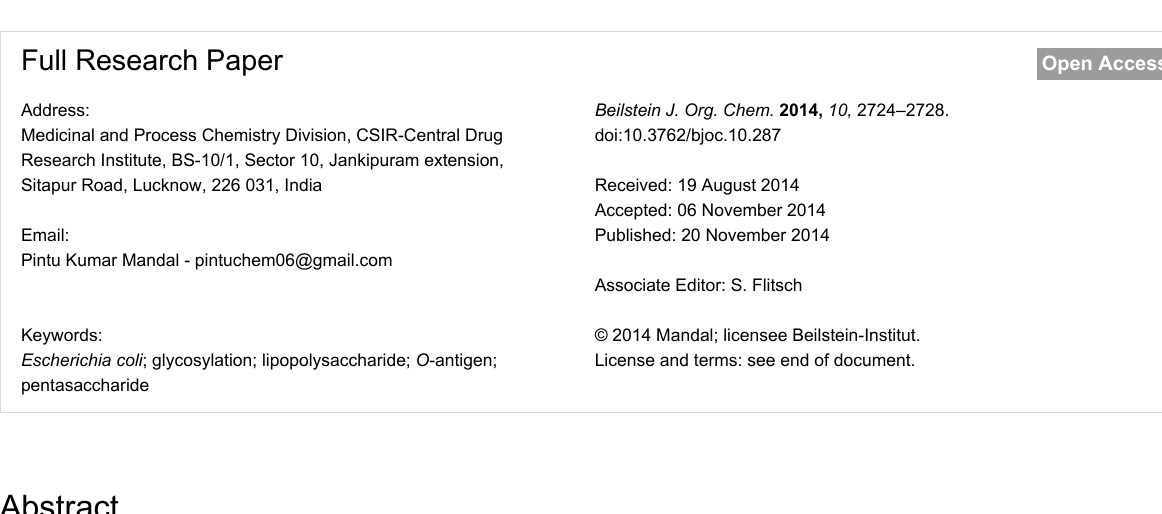
Figure 1: Structure of the pentasaccharide repeating unit of the O -specific polysaccharide of E. coli